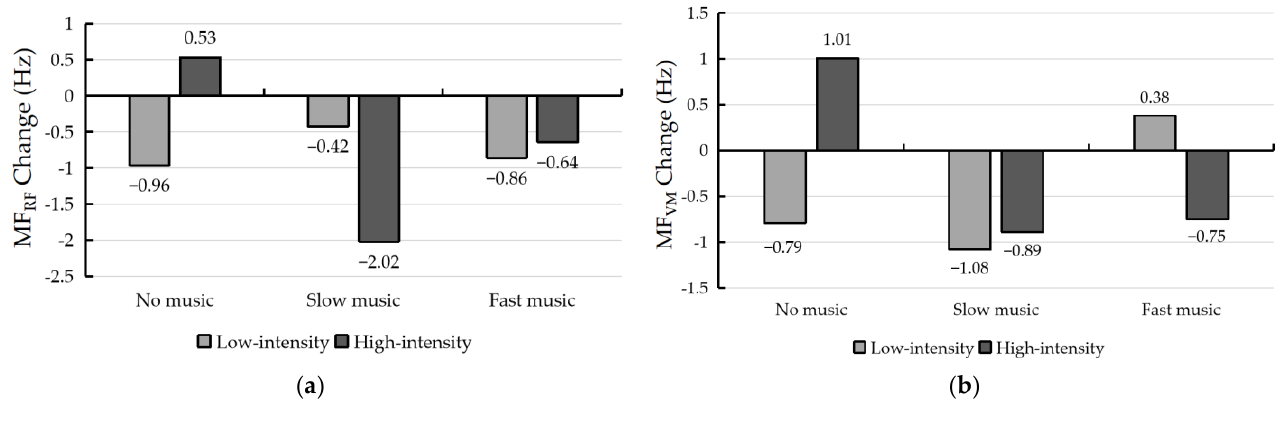
Figure 6. ( a ) MF differences of rectus femoris before and after running under different experi- mental conditions; ( b ) MF differences of vastus medialis before and after running under different experimental conditions.